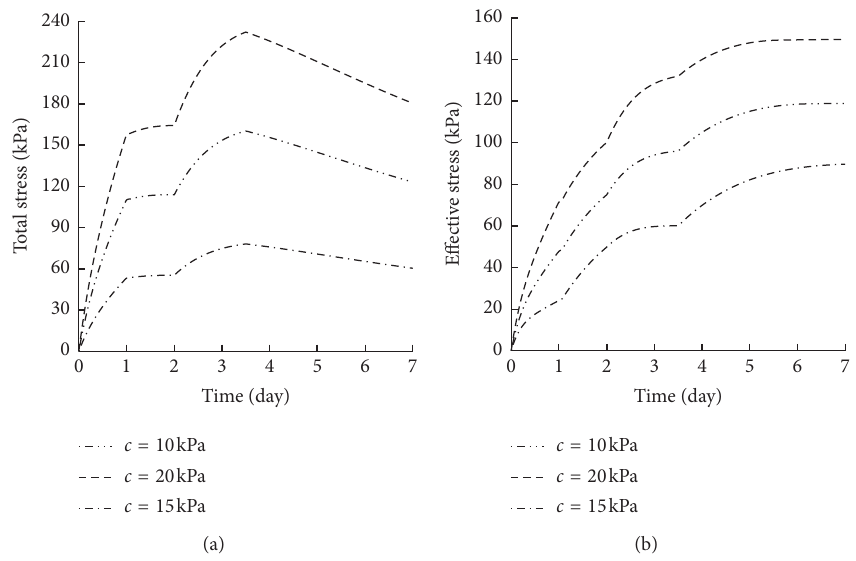
Figure 8: Effect of interface adhesion on the development of (a) total stress and (b) effective